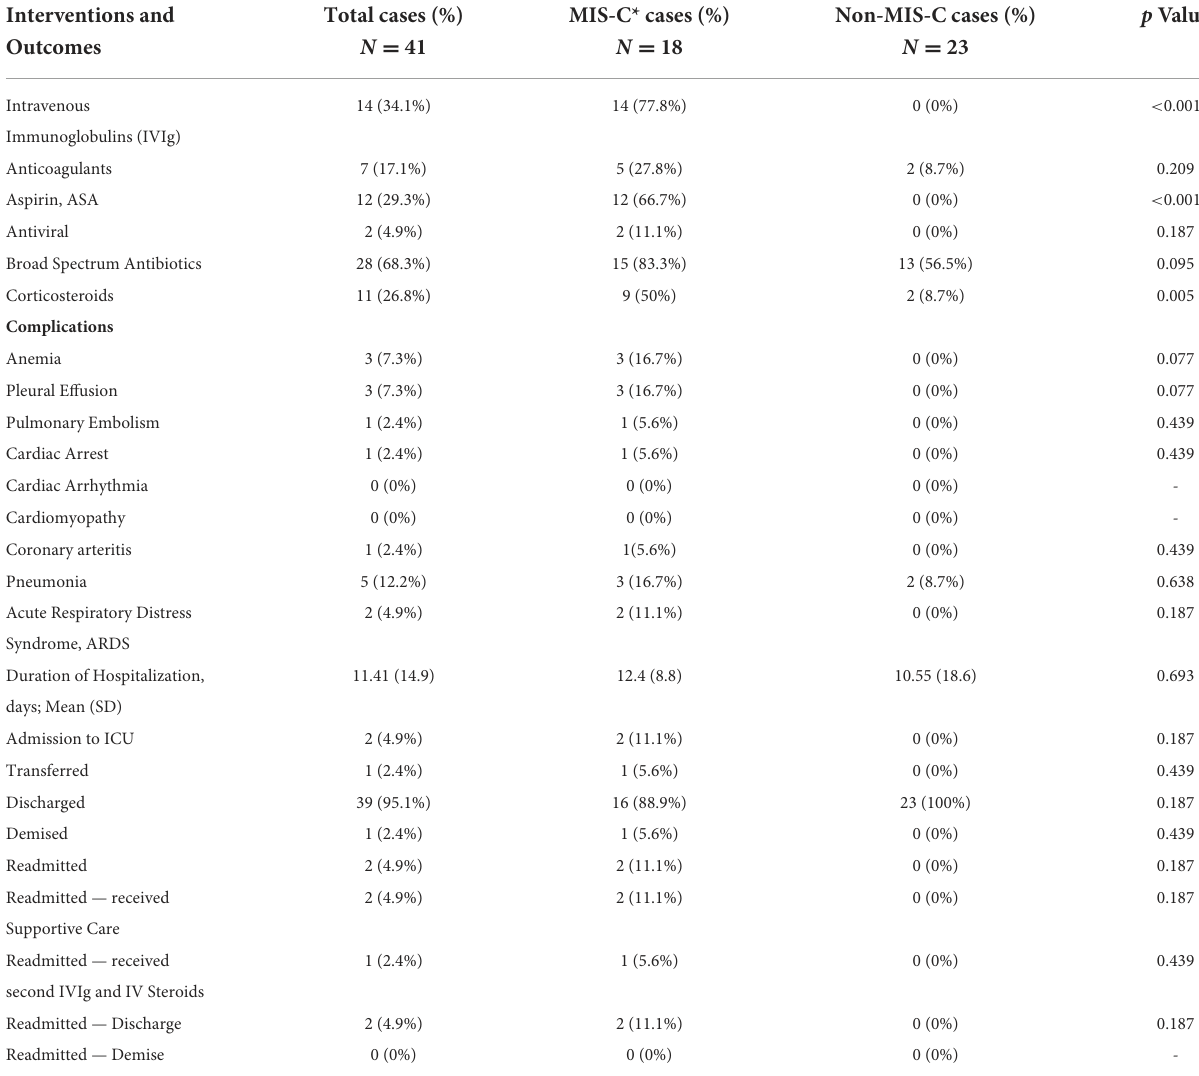
TABLE 5 Medical Intervention and outcomes of children hospitalized with COVID-19, MIS-C * vs. non-MIS-C. Interventions and Total cases (%) MIS-C* cases (%) Non-MIS-C cases (%) p